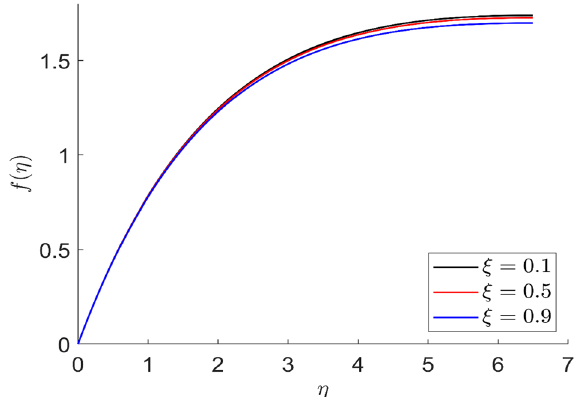
Figure 23. Representation of axial velocity f (η) for the different values of ξ with R = 3, n = 3, u = 0.2, m = 2.5, φ 2 = 0.8, φ = 0.3, φ 1 = 0.1, β 3 = 0.5, β = 0.4, β 1 = 0.5, β 2 = 0.9, Pr = 0.6, v = 0.1.